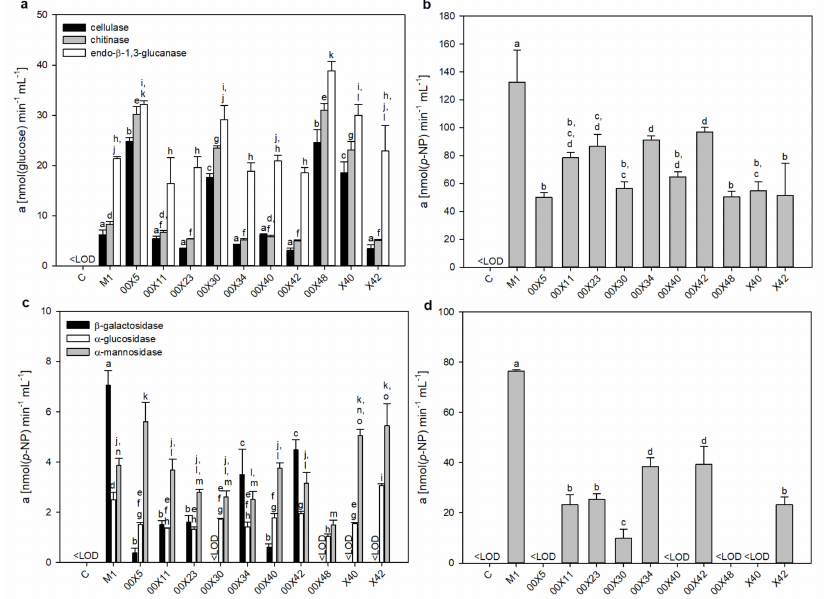
Figure 4. Activities of endo- and exoglycosidases secreted into the medium by Pythium strains. Cellulase, chitinase, and endo- β -1,3-glucanase activities ( a ); β -glucosidase activity ( b ); β -galactosidase, α -glucosidase, and α -mannosidase activities ( c ); β -galactosidase activity in alkaline pH 9.0 ( d ). Each code (00X5, 00X11, 00X23, 00X30, 00X34, 00X40, 00X42, 00X48, X40, X42, and M1) represents a Pythium strain. Control (C) is a sterile, non-inoculated cultivation medium. The di ff erent letters above each bar denote significant di ff erences ( p ≤ 0.05) between groups according to one-way ANOVA (Bonferroni